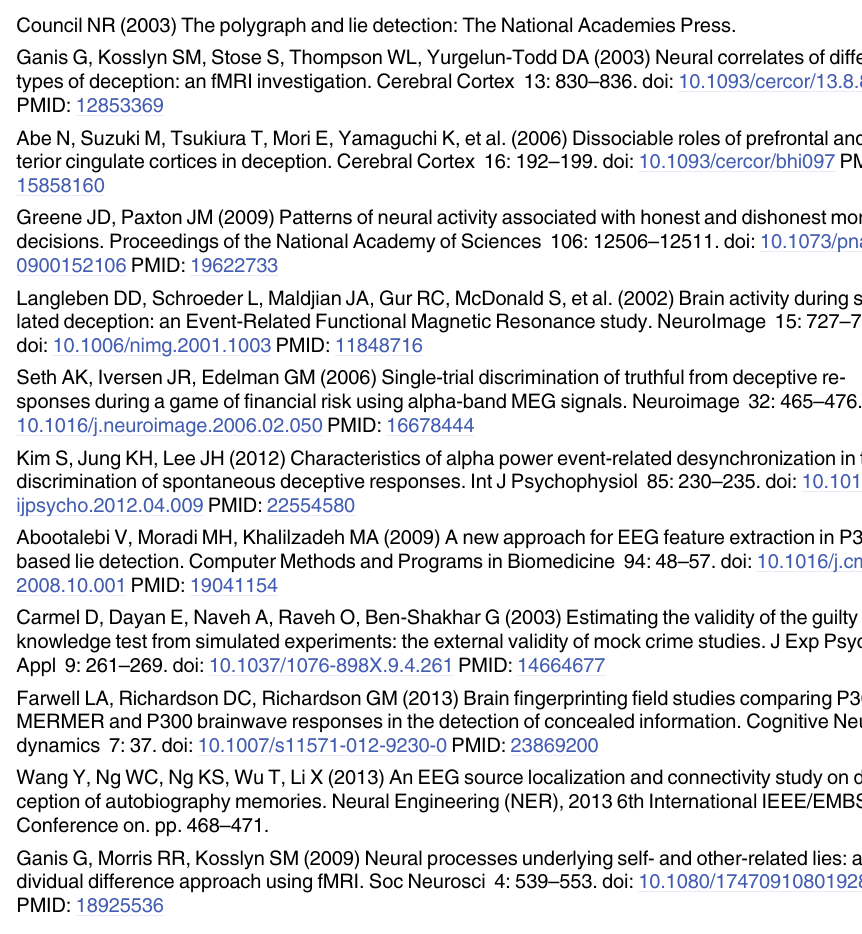
S1 Table. Example questions for the instructed lying and truth-telling conditions in the WE task. S2 Table. Example questions for the instructed lying and truth-telling conditions in the NE